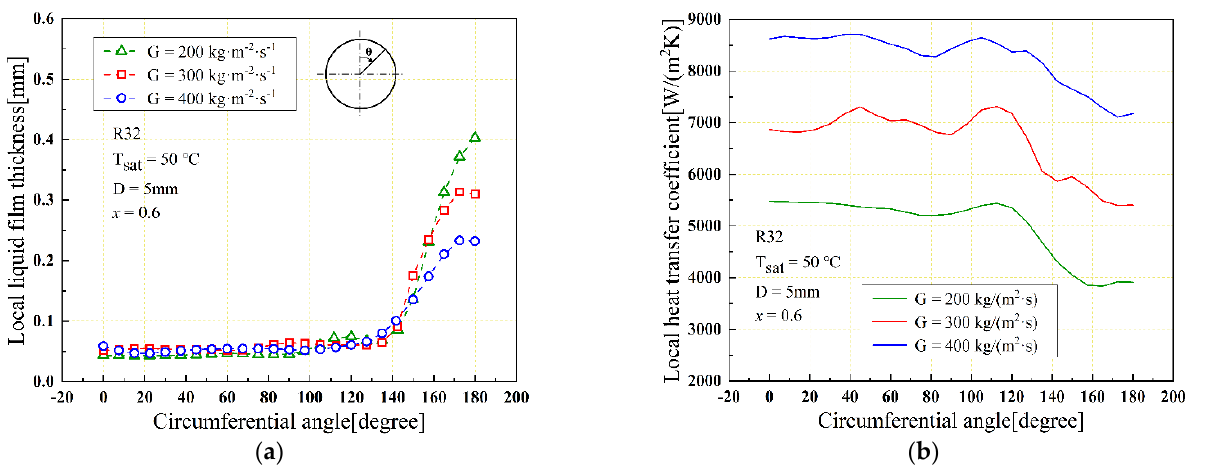
Figure 7. Local liquid film thickness and local heat transfer coefficient versus circumferential angle at different mass flux under vapor quality x = 0.6. ( a ) Local liquid film thickness; ( b ) local heat transfer coefficient.